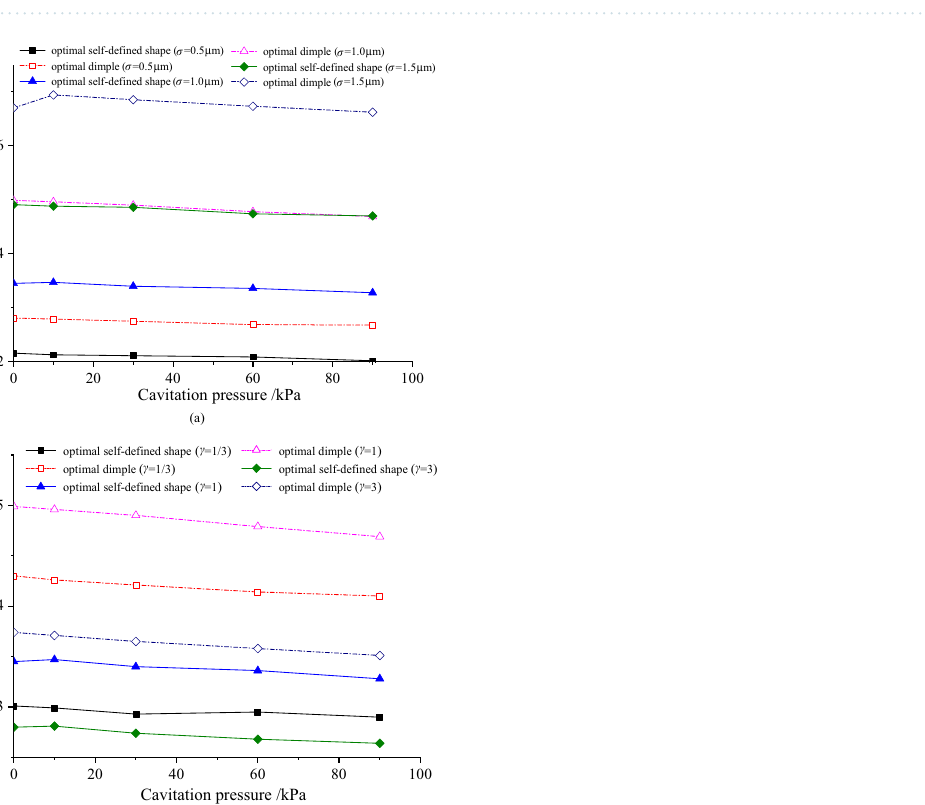
Figure 9. Variation of the friction coefficient with sliding velocity.